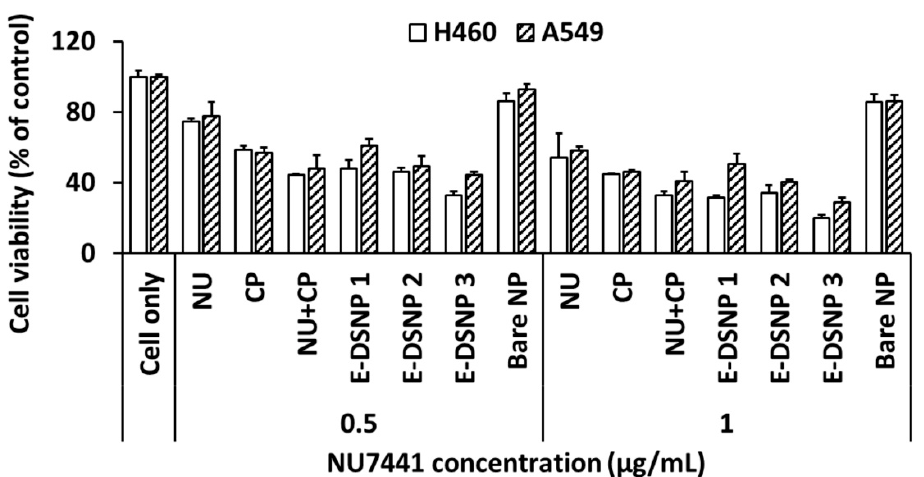
Figure 6. In vitro cancer cell killing efficacies of E-DSNPs. Dual drug loaded DSNPs observed significantly lower cell viability compared to DSNPs encapsulating NU7441 only or Cisplatin only (DSNP1: DSNP with NU7441 only; DSNP 2: DSNP with Cisplatin only, and DSNP 3: DSNP with NU7441+Cisplatin). NU: NU7441 and CP: Cisplatin.